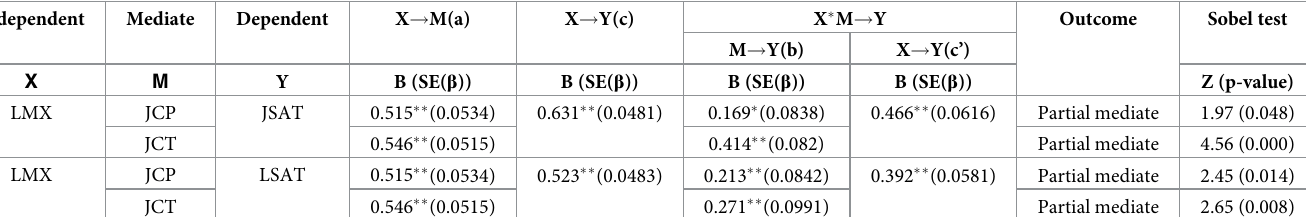
Table 4. Mediating effect of job